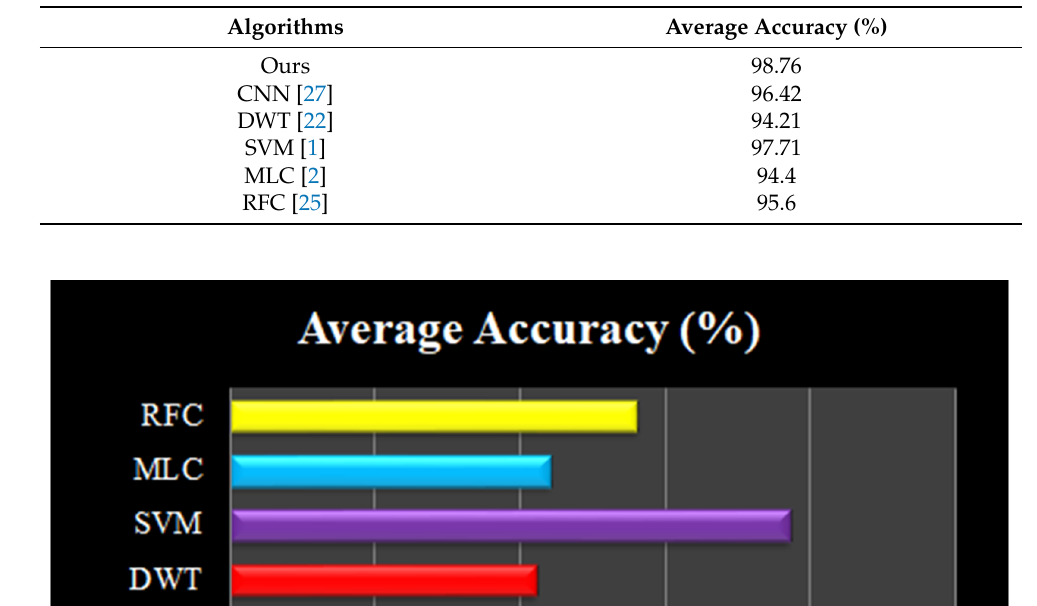
Table 13. Testing of the Vision Transformer–based Bi-LSTM model using the various combinations of Input Spatial Data for Javadi Hills, India.